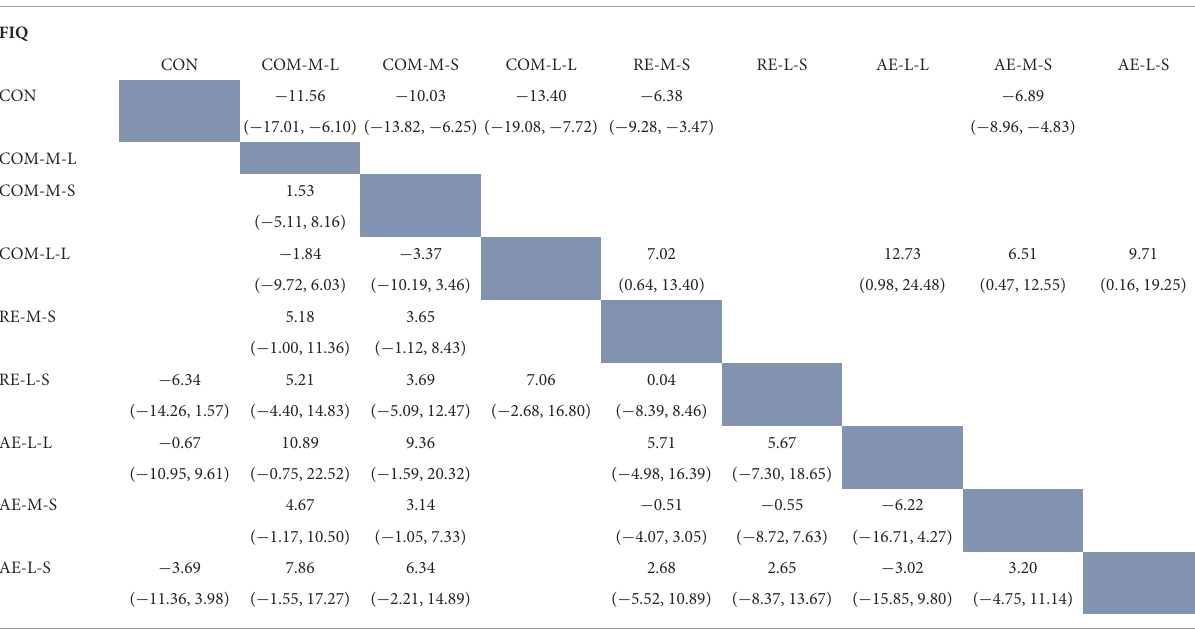
TABLE 3 Network meta-analysis matrix of results (FIQ). Outcome Comparison of treatments: Mean difference (95% confidence intervals) effect of intervention in each row compared with intervention in each column